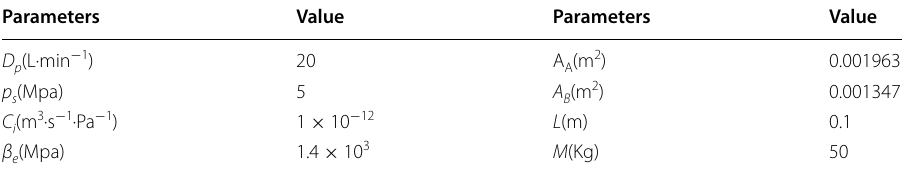
Table 2 The hydraulic system parameters Parameters Value